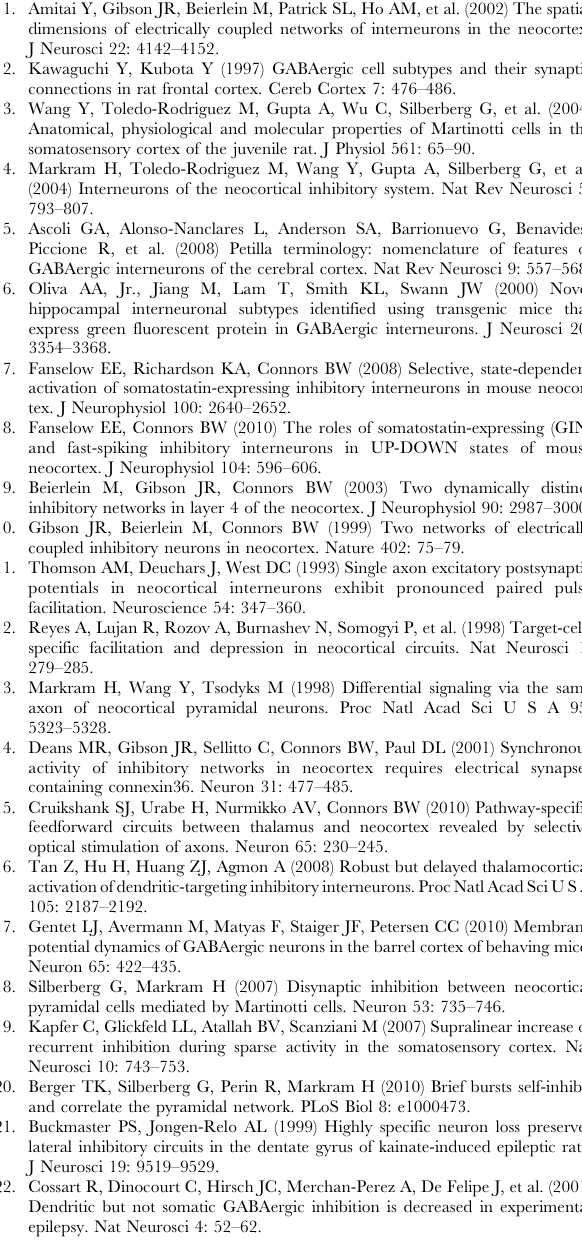
grey area, both states are stable. (C) Traces of M R (solid line) and almost exclusively during the periods when RS neuron